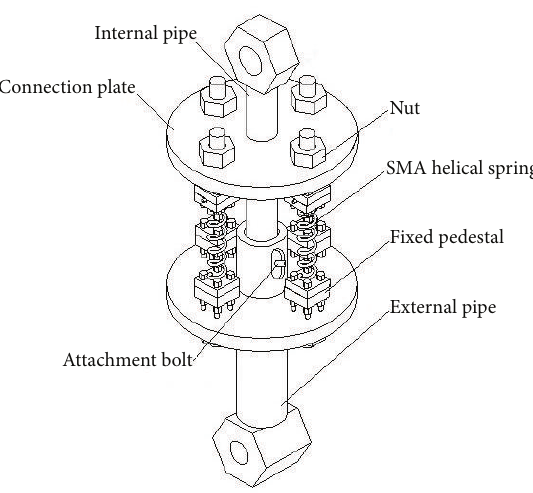
Figure 1: Schematic diagram of SMA spring restrainer.